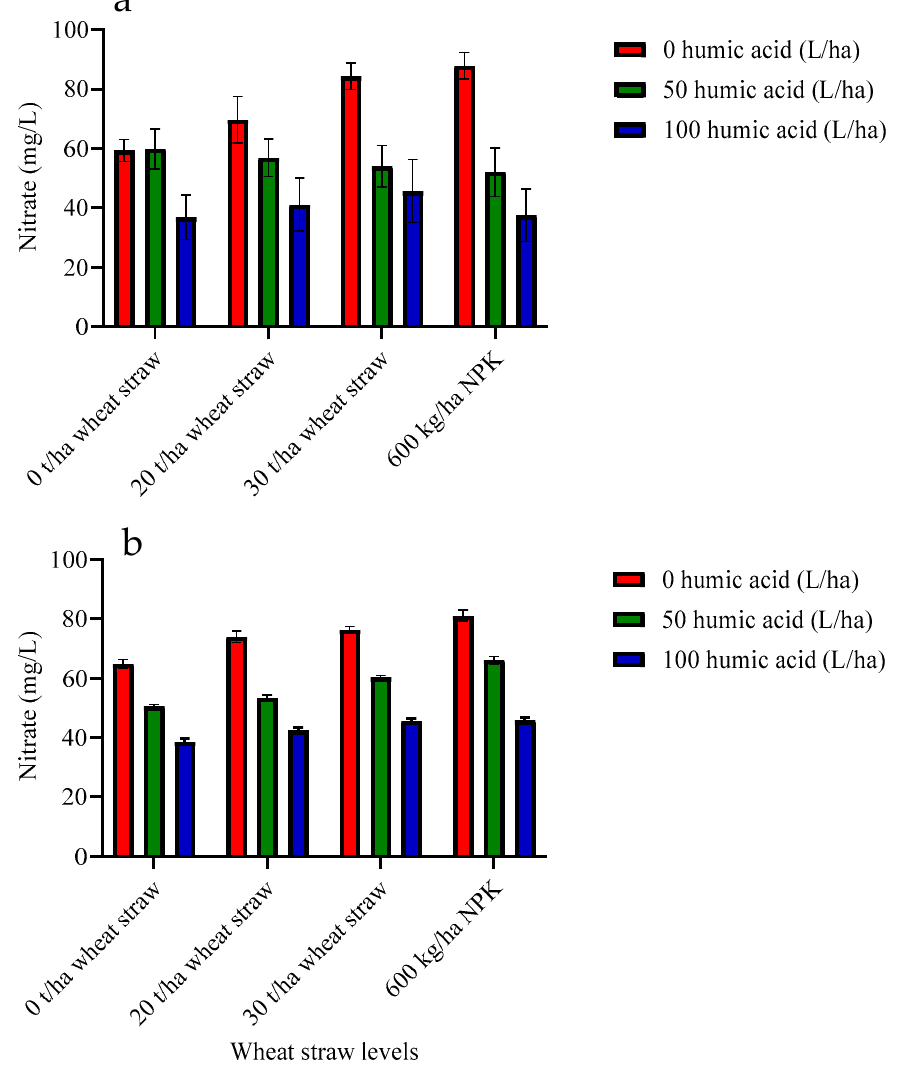
Figure 4. Interaction effects of wheat straw and humic acid levels on squash fruit’s nitrate content in ( a ) 2020 and ( b ) 2021 planting seasons. Bars indicate ± standard error, and error bars that are not overlapping each other indicate that the means are significantly ( p ≤ 0.05) different from each other.